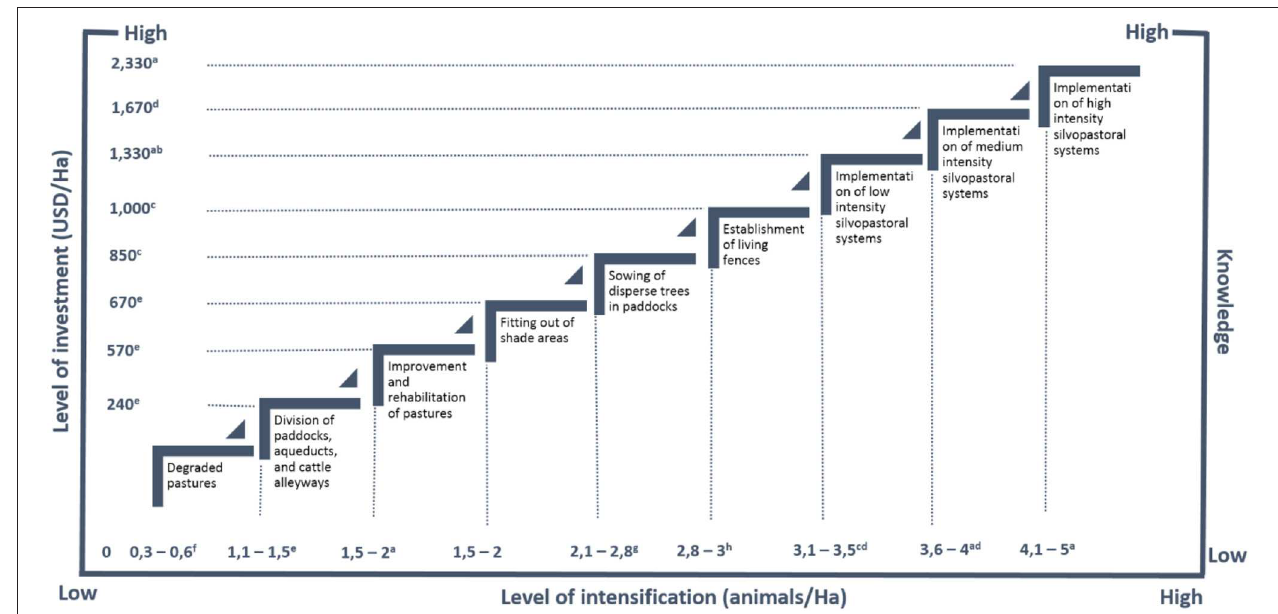
FIGURE 4 | Scale of technologies for implementation in productive livestock systems 11